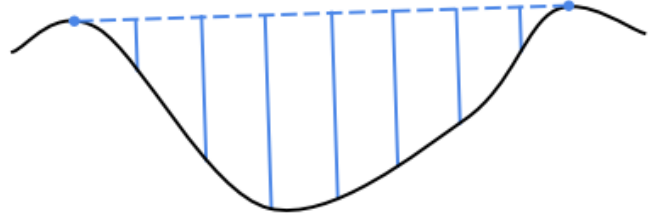
Figure 6. Skyline features of concavity.